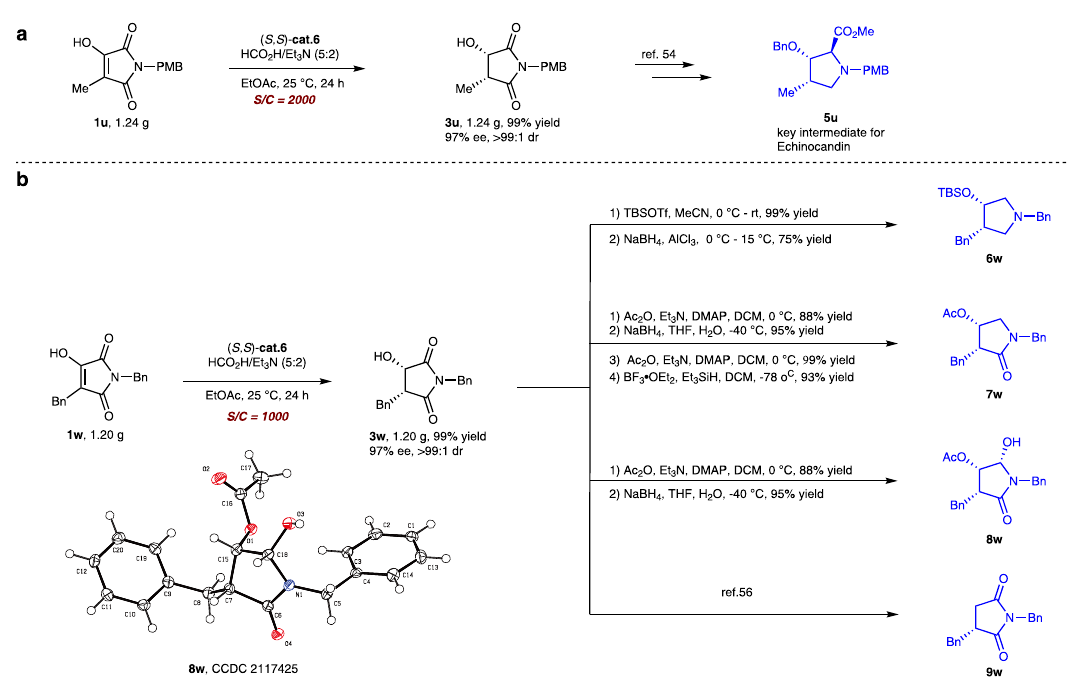
Fig. 4 | Gram scale synthetic utilities of the DKR-ATH process. a Gram-scale experiment of 1u . b Gram-scale experiment of 1w and transformations of product 3w